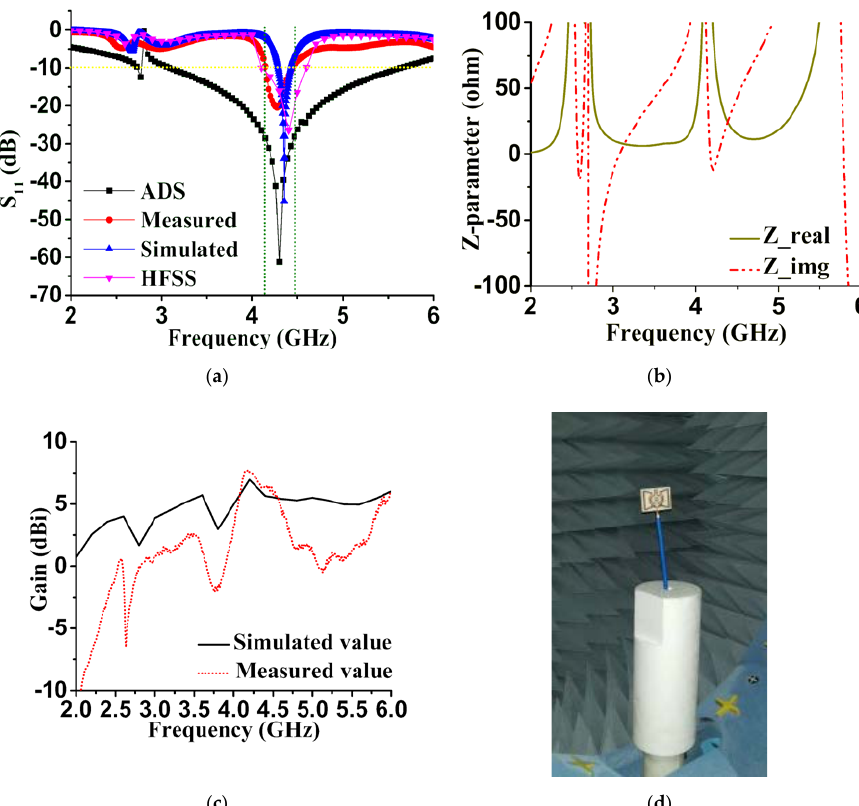
Figure 8. Experimental and simulated results’ comparison; ( a ) Reflection coe ffi cient (S 11 ) performance; ( b ) Numerical plotting of characteristic impedance (Z); ( c ) antenna measurement at Sattimo StarLab; ( d ) Gain (dBi) of the proposed